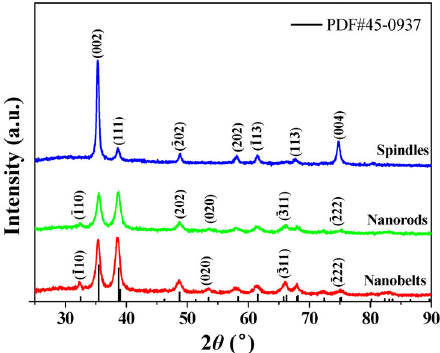
Fig. 6 FTIR spectra of CuO nanostructures with different